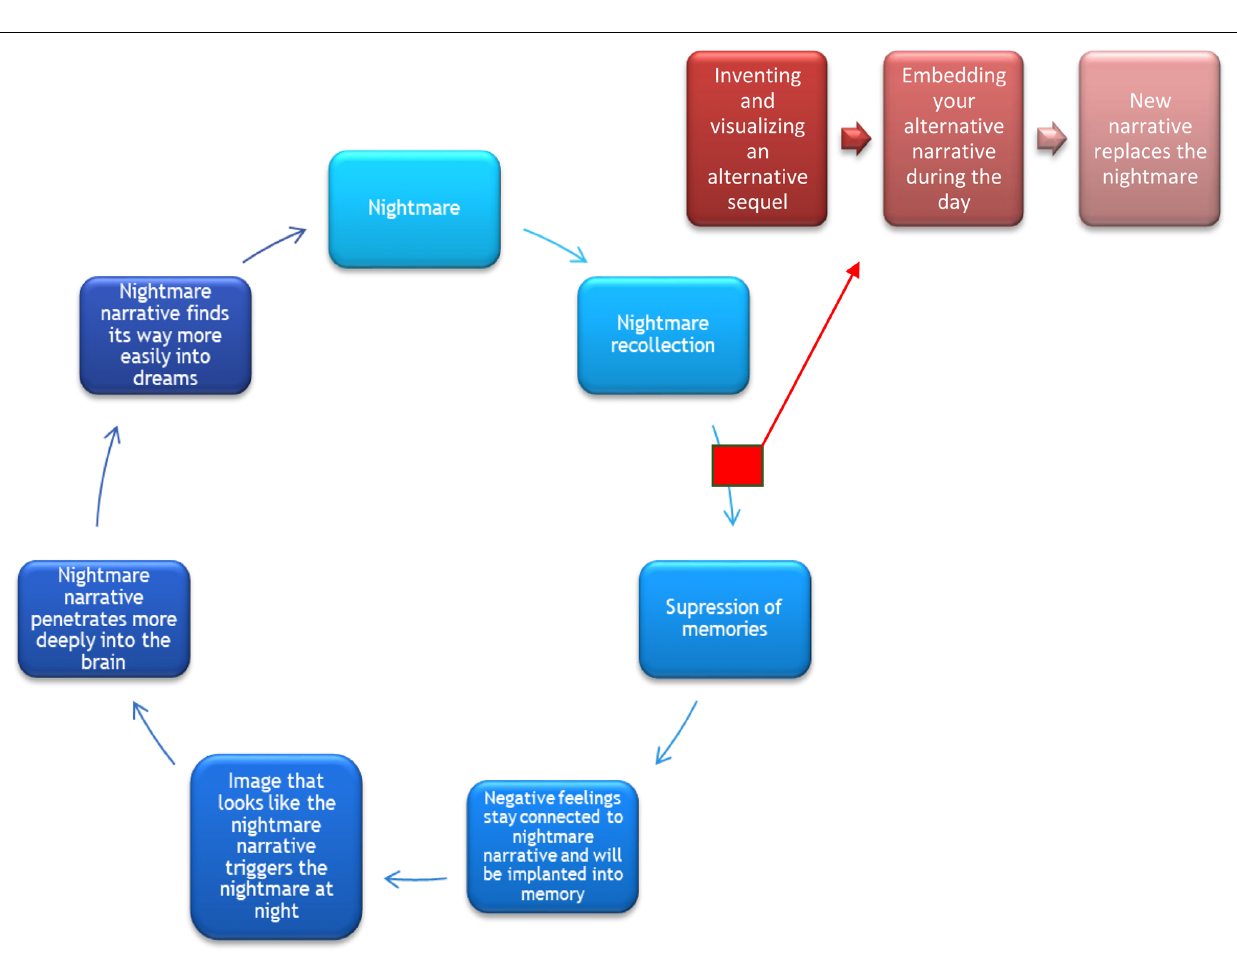
adults suffering from nightmares following PTSD